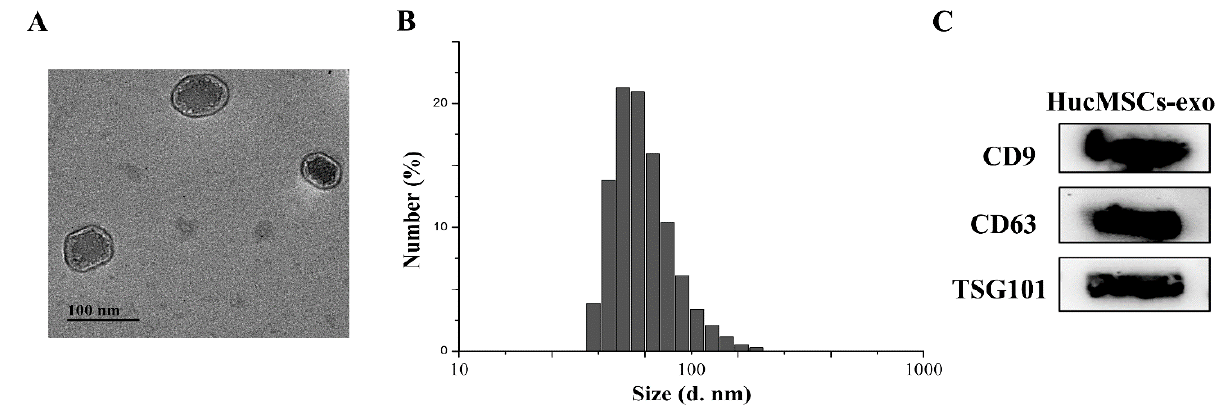
Figure 1. Characterization of hucMSCs-exo. ( A ) TEM micrograph of hucMSCs-exo. The scale bar is 100 nm. ( B ) Particle size and distribution analysis of hucMSCs-exo by Zetasizer Nano ZS. ( C ) Western blotting analysis of hucMSCs-exo markers.